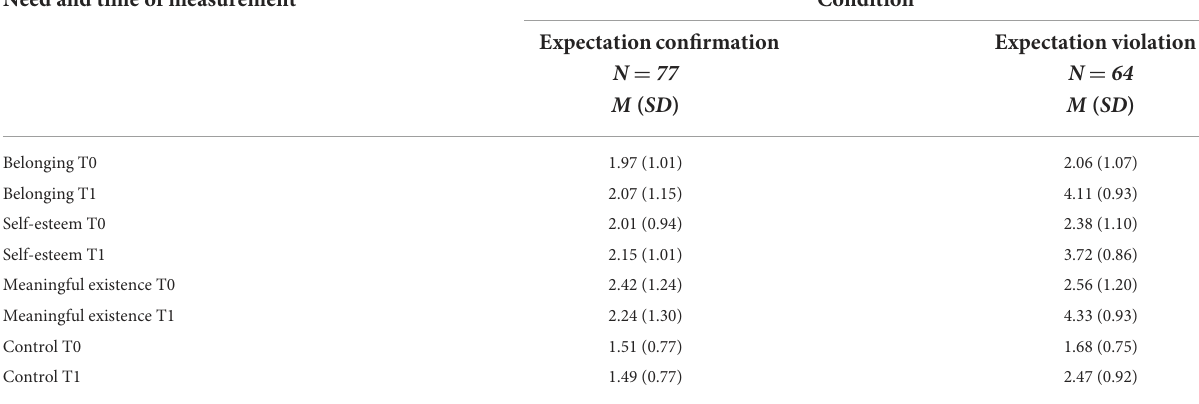
TABLE 2 Additional analysis: comparison of the two experimental conditions regarding the self-rating on reflexive needs ( N = 141). Need and time of